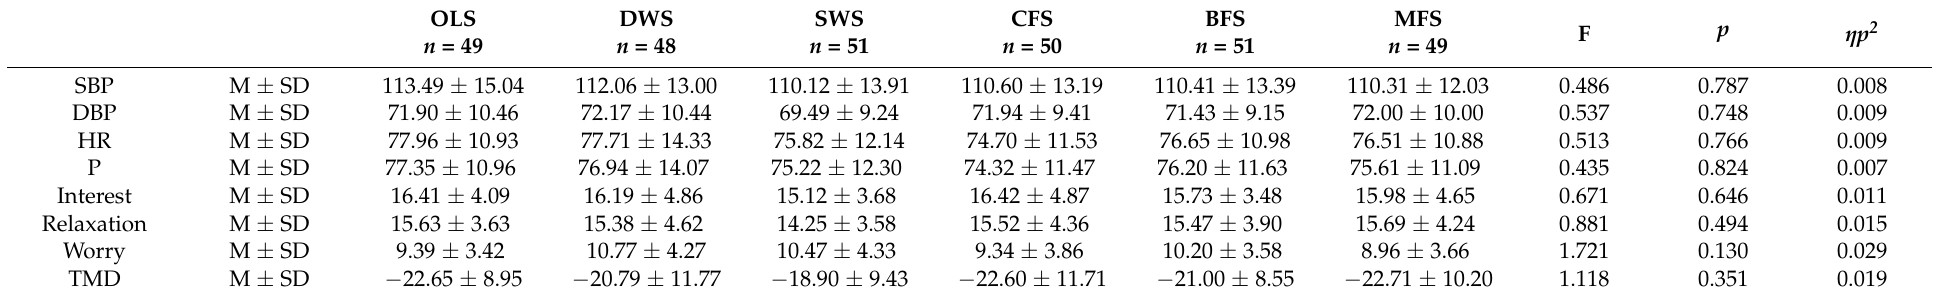
Table 3. ANOVA of various indicators before VR in different forest